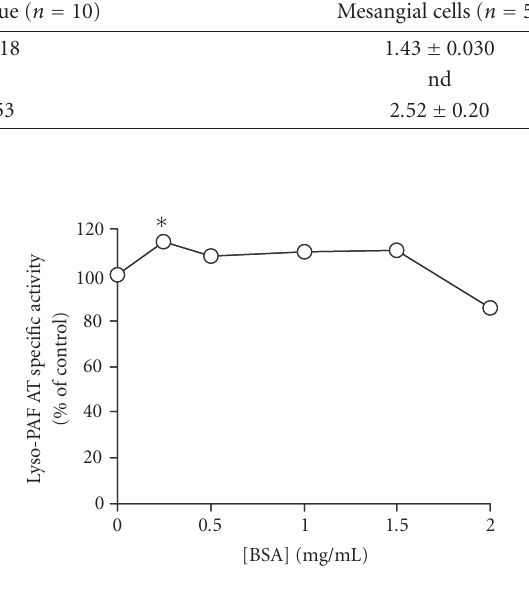
Table 1. Subcellular specific activity of lyso-PAF AT from human kidney tissue and mesangial cell preparations. Lyso-PAF AT specific activity (nmol/min/mg) Subcellular fraction